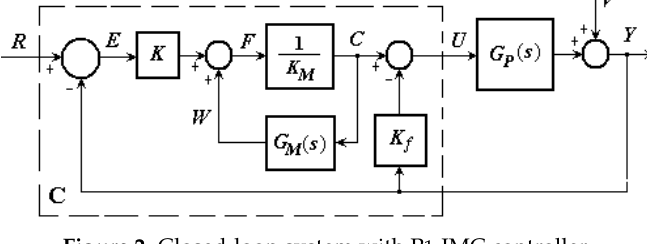
Figure 2. Closed-loop system with P 1 -IMC